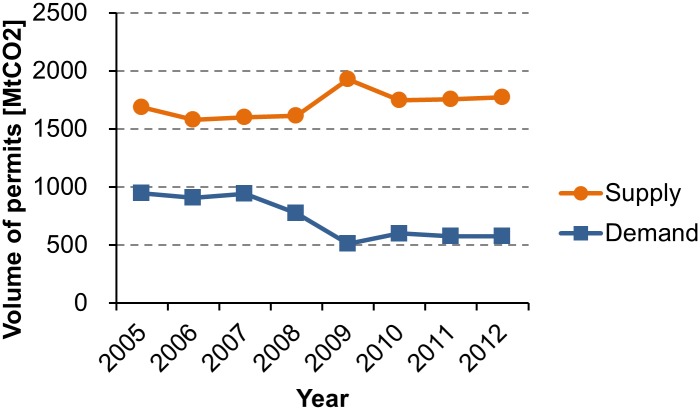
Aggregate permit supply and demand in Annex B Parties, 2005–2012.Calculated from CO2 emission data [24] and the QELRC of the Kyoto Protocol [5]. The US is not included.